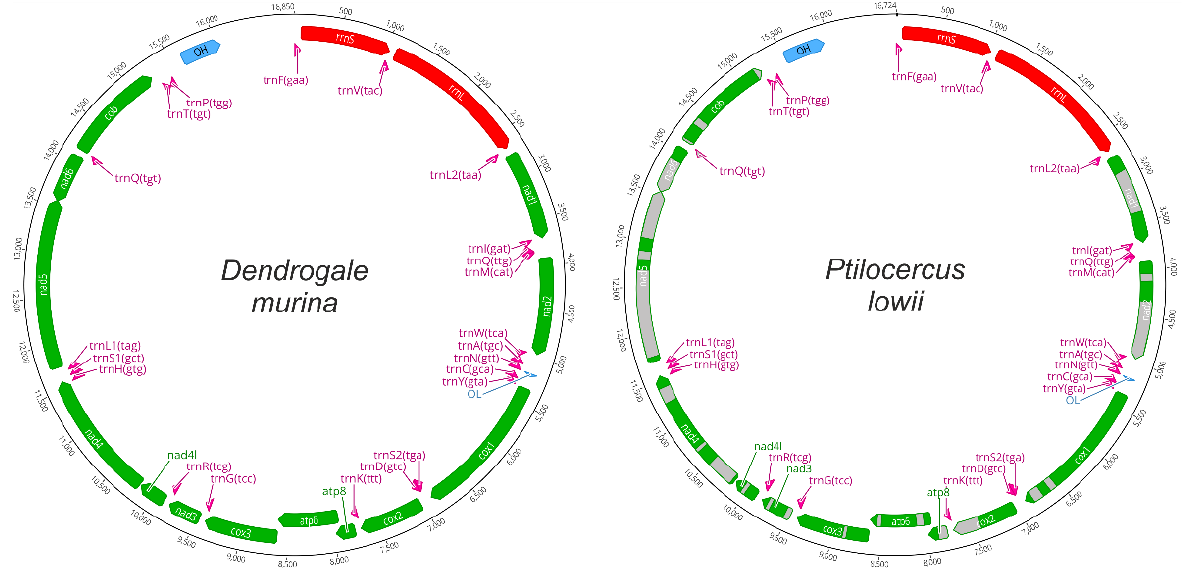
Figure 2. Map of the mitochondrial genomes of Dendrogale murina and Ptilocercus lowii . Green pointed bands mark annotations of protein-coding genes (CDs); rRNAs are marked in red, tRNAs in violet, and OH and OL (origins of heavy and light strand replication, respectively) colored with blue. consensus sequence are marked in grey. Map of mitochondrial genomes was visualized in Geneious Prime 2019.1 and edited manually in CorelDRAW X8. Table 1. List of the 13 protein-coding genes in the mitochondrial genomes of Dendrogale murina and Ptilocercus lowii